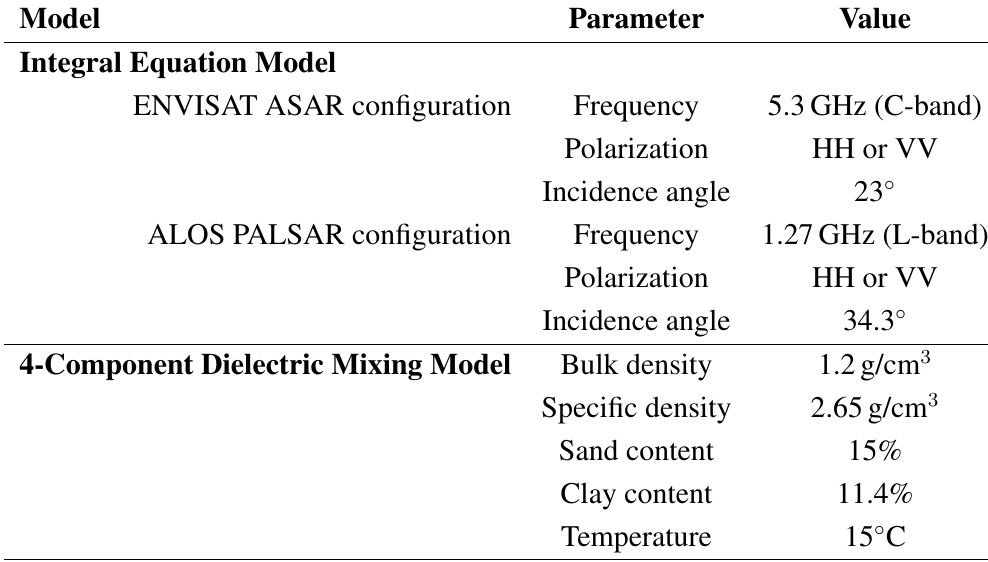
Table 1. Input parameters used for the IEM and the four-component dielectric mixing